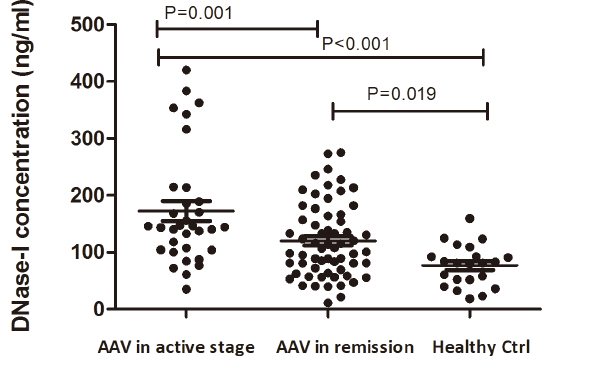
Fig 4. Circulating DNase I concentration in AAV